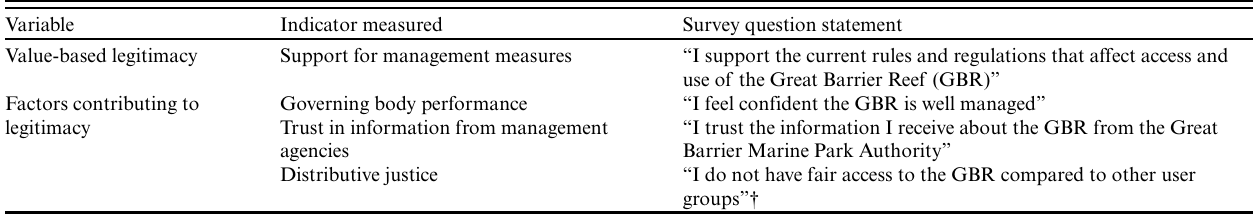
Table 1. Dependent and explanatory variables derived from survey question statements. Responses to all question statements were measured using a 10-point ordinal scale (1 = very strongly disagree, 10 = very strongly